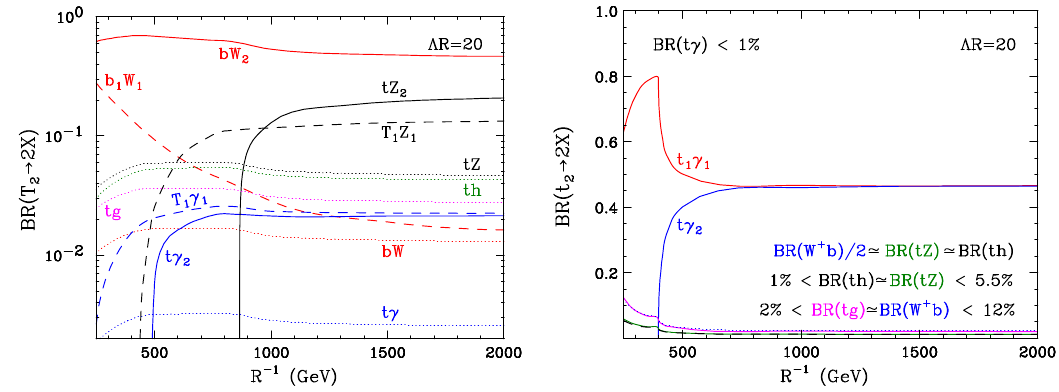
Figure 13 . Branching fraction of SU(2) L -doublet KK top quark (left) and SU(2) L -singlet KK top quark